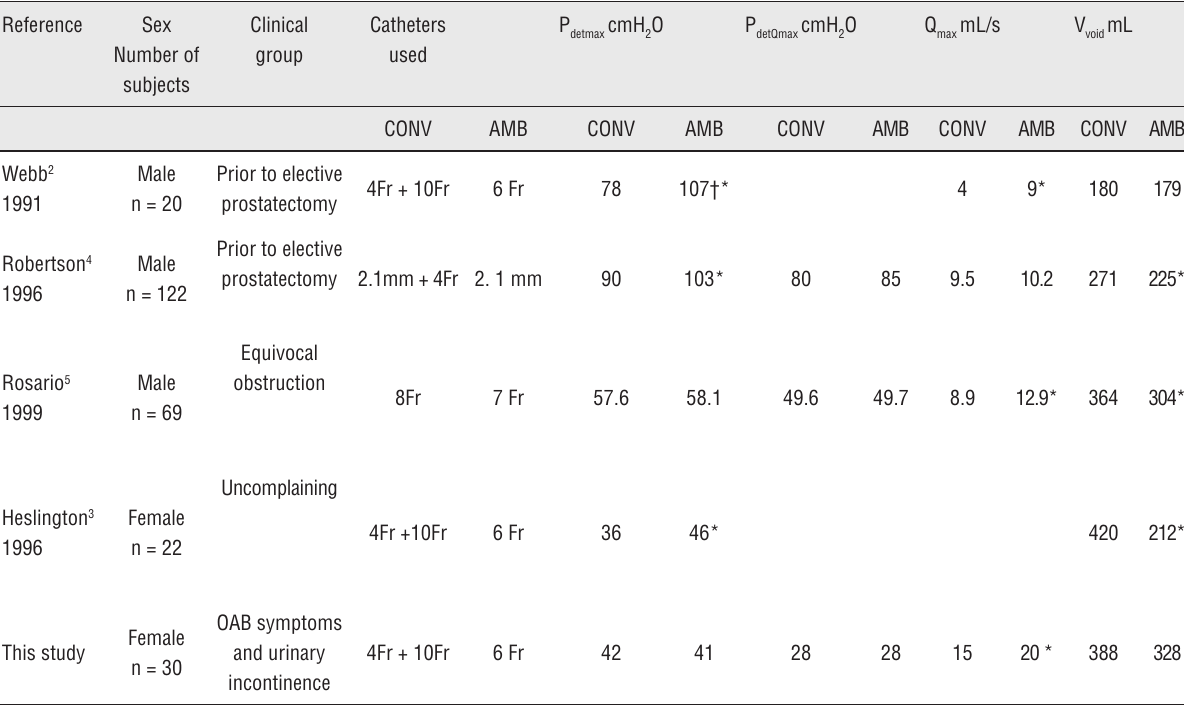
Table 3 - Comparative urodynamic measurements from conventional cystometry (CONV) and ambulatory urodynamic monitoring